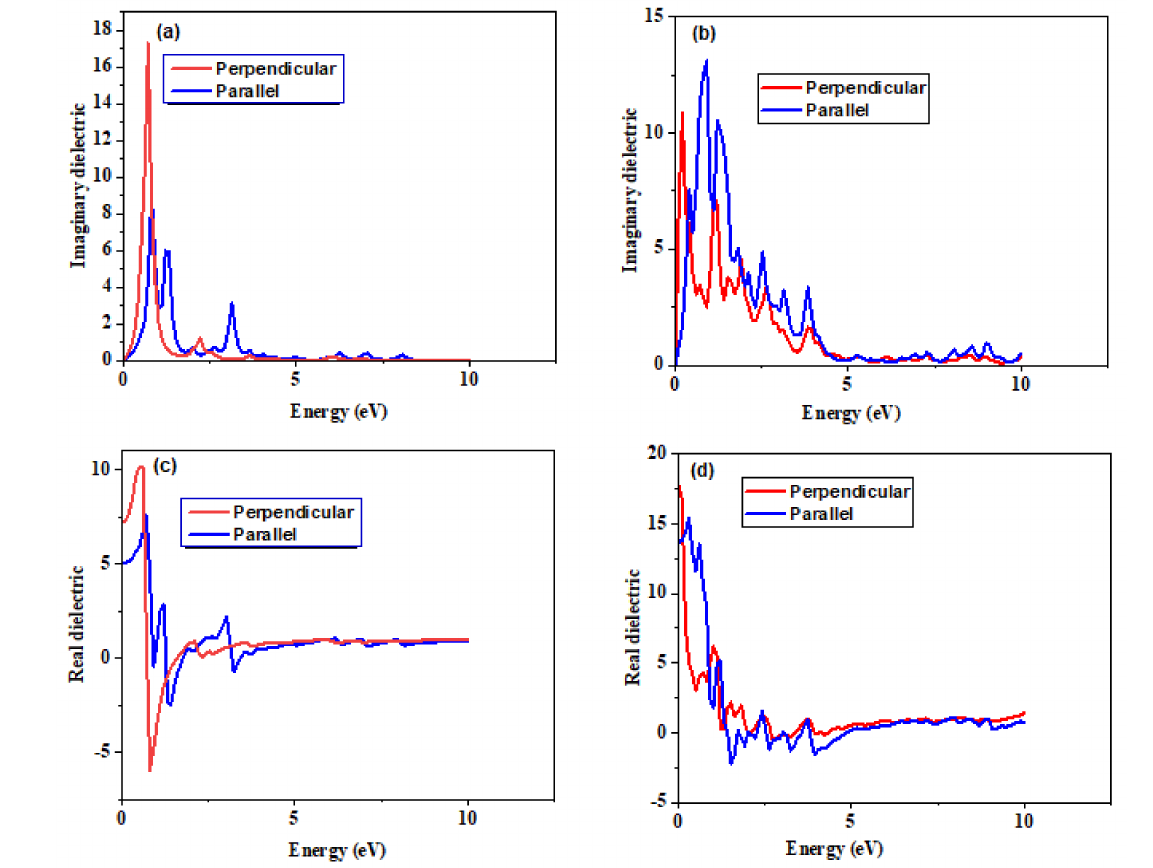
Figure 3. Dielectric functions of (5, 5) SWBNNT and SWCNT systems. ( a ) Imaginary dielectric for (5, 5) SWBNNT, ( b ) imaginary dielectric for (5, 5) SWCNT, ( c ) real dielectric for (5, 5) SWCBNNT, and ( d ) real dielectric for (5, 5)